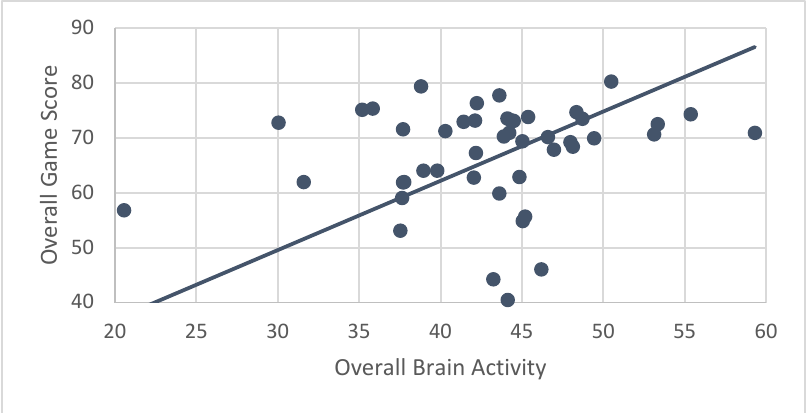
Figure 8. Correlation between performance (game scores) and brain activity for the treatment (ABC) group. Mean levels of brain activity during ABC training were significantly associated with performance on the ABC games (r = 0.84, p <